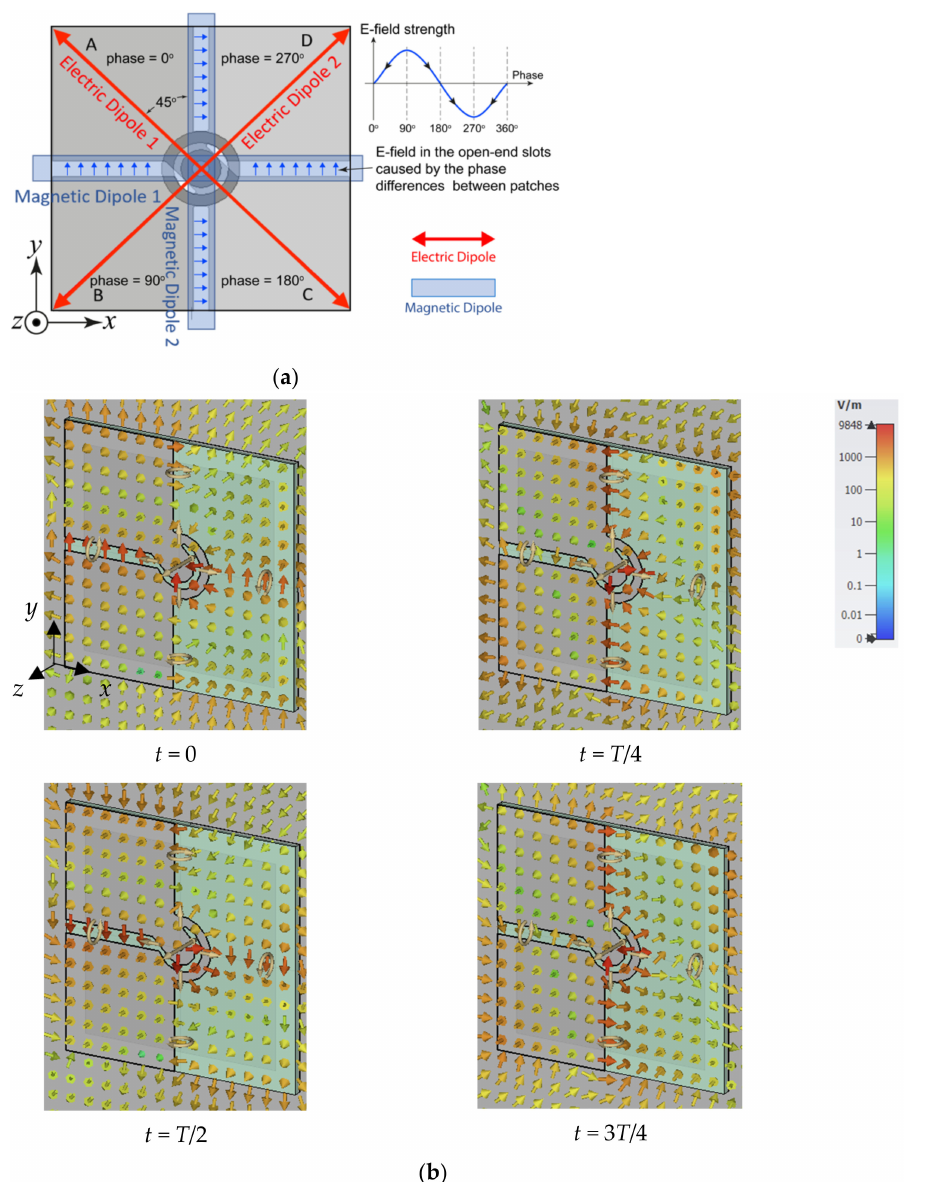
Figure 2. ( a ) The four fundamental modes of the proposed CP cavity-less ME dipole antenna, ( b ) E -field of the magnetic dipole modes at t = 0, T /4, T /2, and t = 3 T /4 at 4